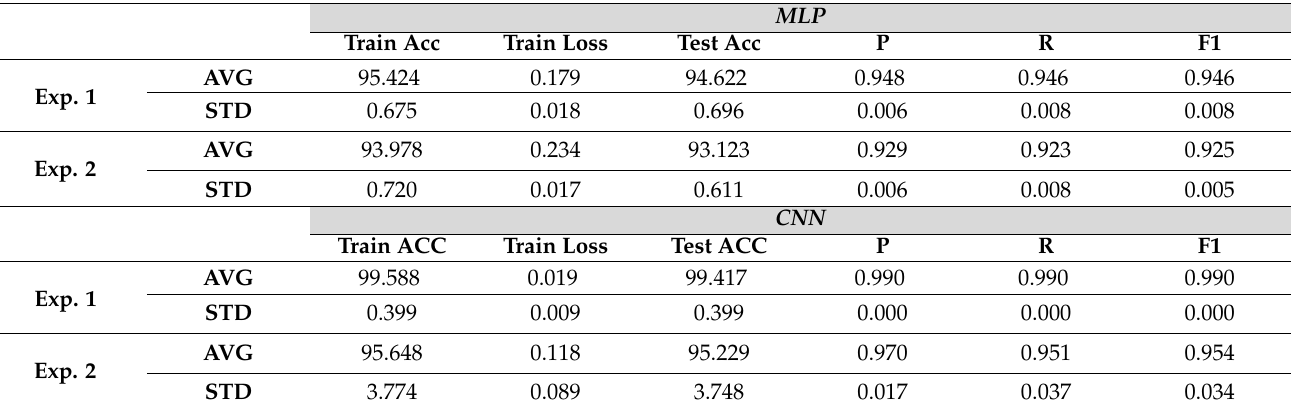
Table 4. Average accuracy, precision, recall, and F1 score of the two models, evaluated for the two experiments.